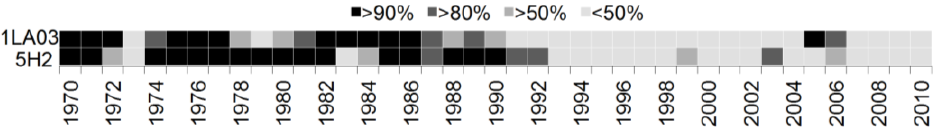
Figure 1. Streamflow data availability for the Nyangores River at Bomet station (1LA03) and the Mara River at Mines station (5H2).